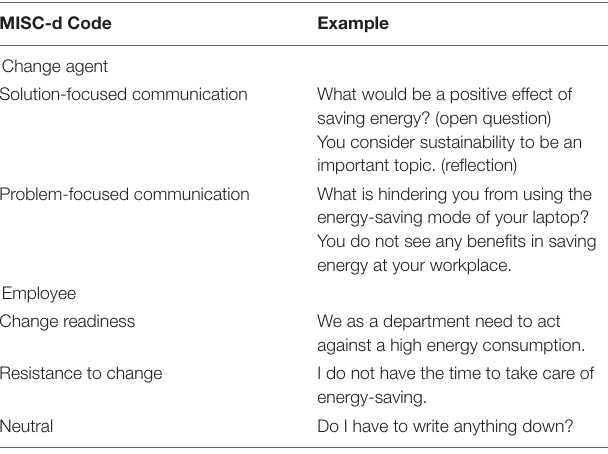
TABLE 1 | Overview of Motivational Interviewing Skill Code (MISC-d) behavior codes. MISC-d